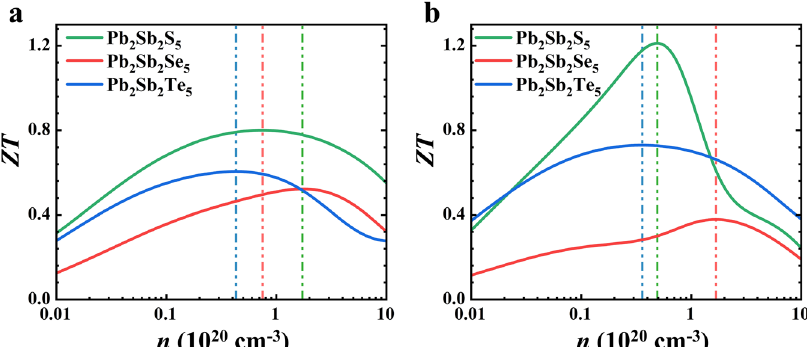
Fig. 9 ZT calculation. ZT values of Pb 2 Sb 2 S 5 , Pb 2 Sb 2 Se 5 , and Pb 2 Sb 2 Te 5 as a function of a hole (p-type) and b electron (n-type) carrier concentrations at 650 K. The dotted lines indicate the optimal carrier densities that achieve the ZT max of each